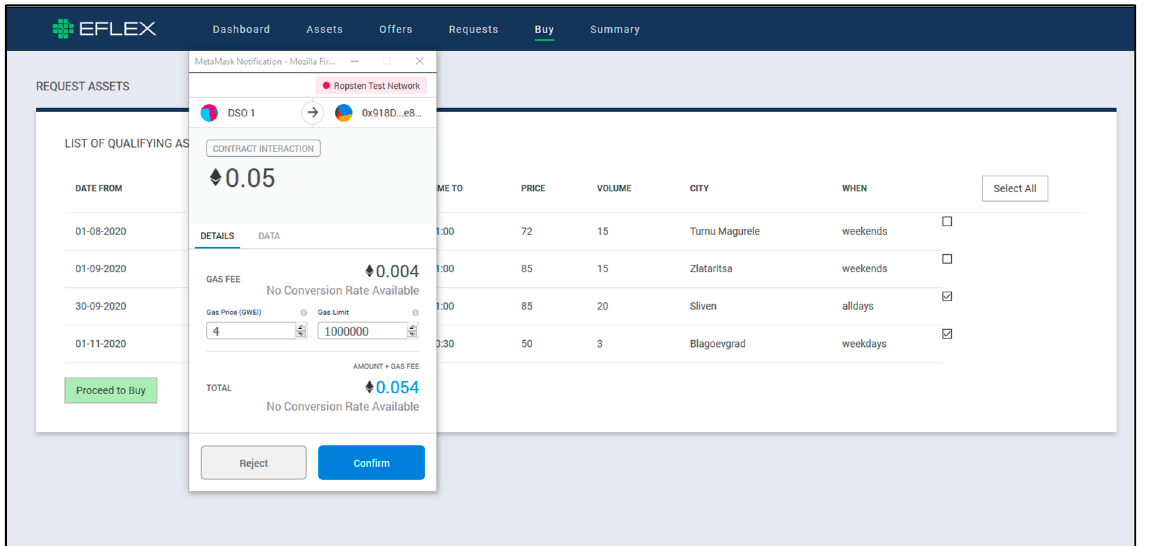
Figure 21. Flexibility assets in Romania.